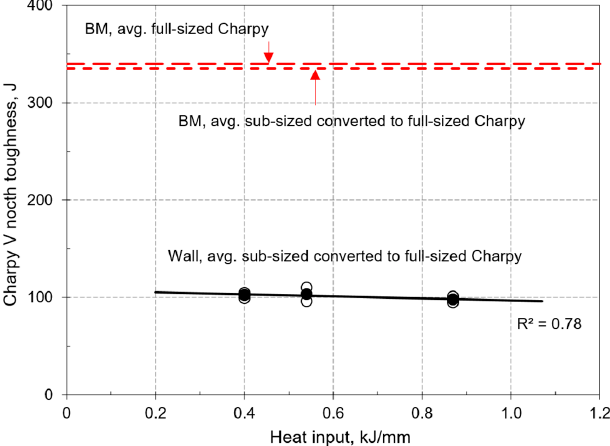
Figure 8. Charpy V-notch toughness of walls and base metal.